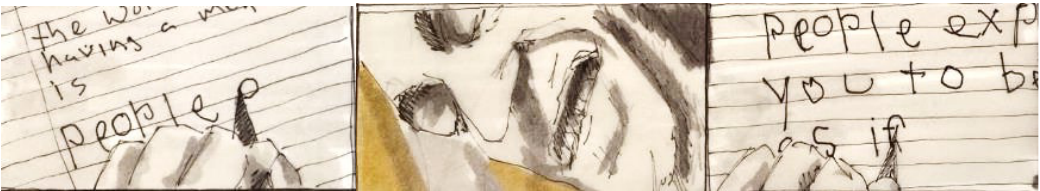
figure of Arthur as he writes in his journal 2 . The scene transitions on Arthur’s journal from the previous scene at the comedy club. We see the space, with gentle side lighting giving the apartment a feeling of warmth. Arthur sits at the dining table by the window to the city – a small figure to the far right of the screen. A warm orange wall-light sits at the same height as his dark head, but the front of his torso is lit up by a bright white pendulum-light over the small table. It also illuminates part of the grid-patterned wallpaper behind. The camera slowly moves towards him, switches to follow his point of view of the text as he scrawls about his daily struggle to be accepted, which he intends to present as comedic. He switches writing with his right hand to his left, amusing himself to counteract the immense despair of his isolation. His smile more closely resembles a grimace as he completes the sentence, amused either by his joke or his perverse attempt at